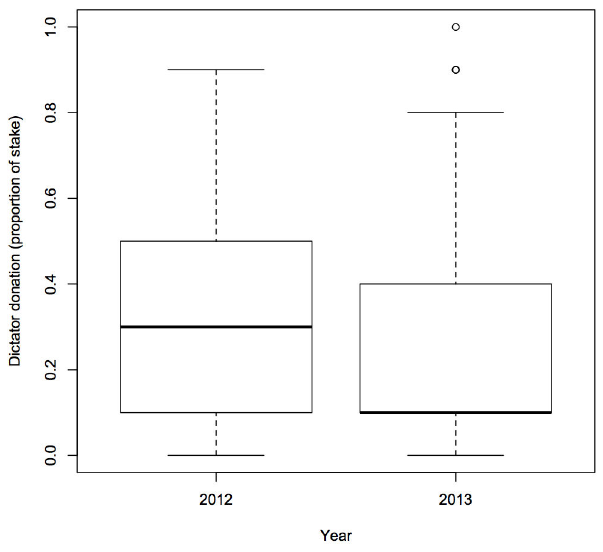
Figure 1. Boxplot of dictator donations (proportion of endowment given to receiver) according to year generated from raw data from Indian players. Solid lines represent medians while the upper and lower boundaries of the box are the upper and lower quartiles of the data. The highest and lowest values in the data (excluding outliers) are indicated by the bars extending from the boxes. Circles represent outliers.